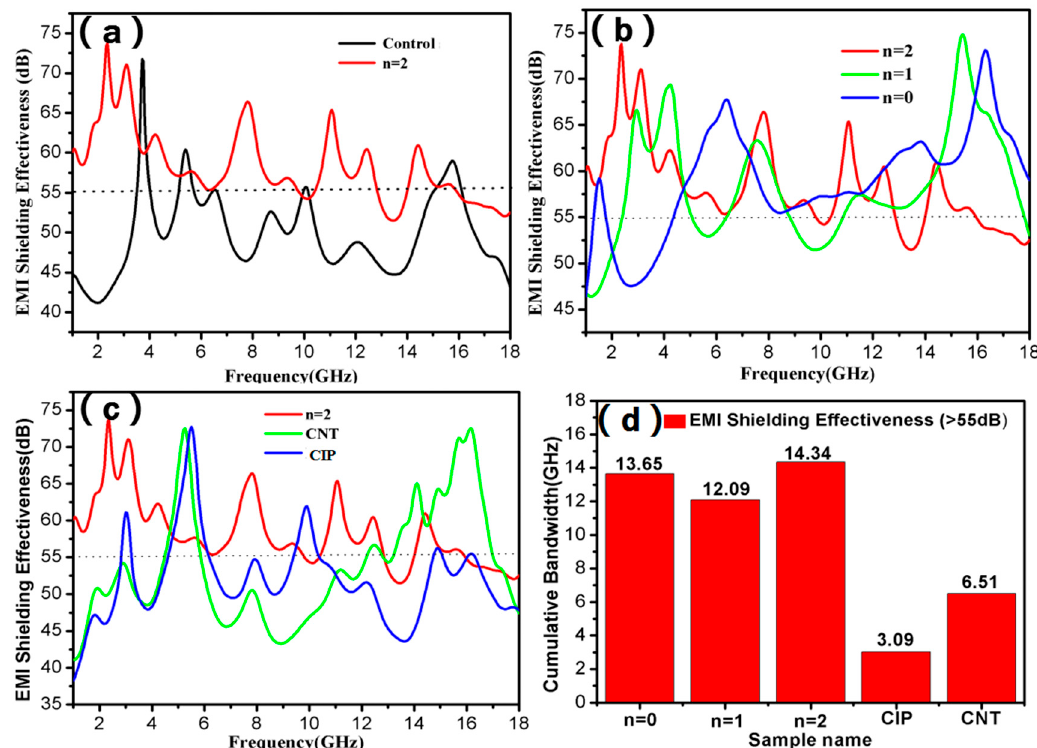
Figure 5. SE–frequency curve comparison of sample with n = 2 and control ( a ), samples with different fractal number ( b ), samples with different fillers ( c ), and cumulative bandwidth values of the SE exceeding 55 dB for all samples ( d ).